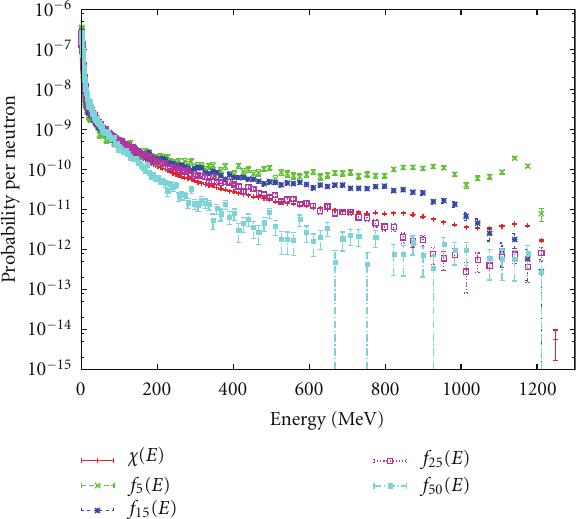
Figure 9: Portion of the low-energy ( < 100MeV) neutrons com- pared to the high-energy ( > 100MeV) neutrons for the di ff erent